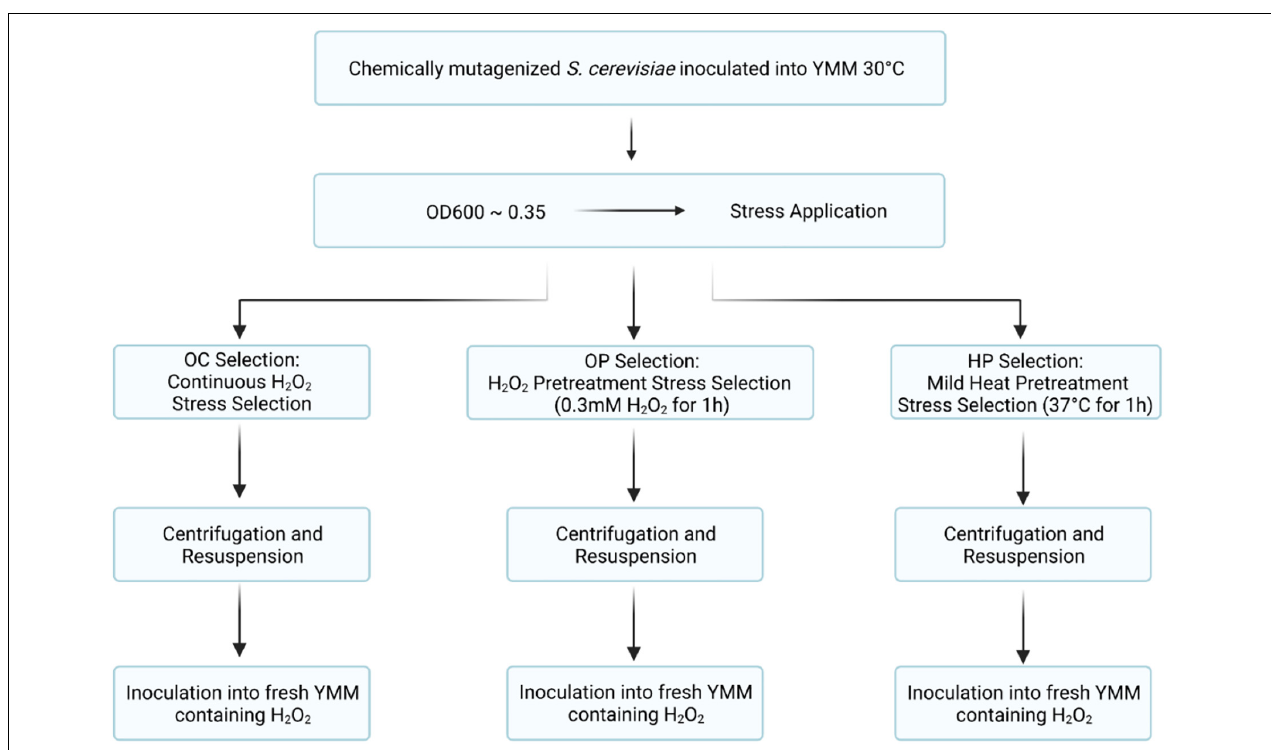
FIGURE 1 | Flow charts of evolutionary selection and preconditioning strategies. Generation and selection of oxidative stress-resistant S. cerevisiae populations using different evolutionary engineering strategies are shown (OC, oxidative continuous; OP, oxidative pulse; HP, heat and